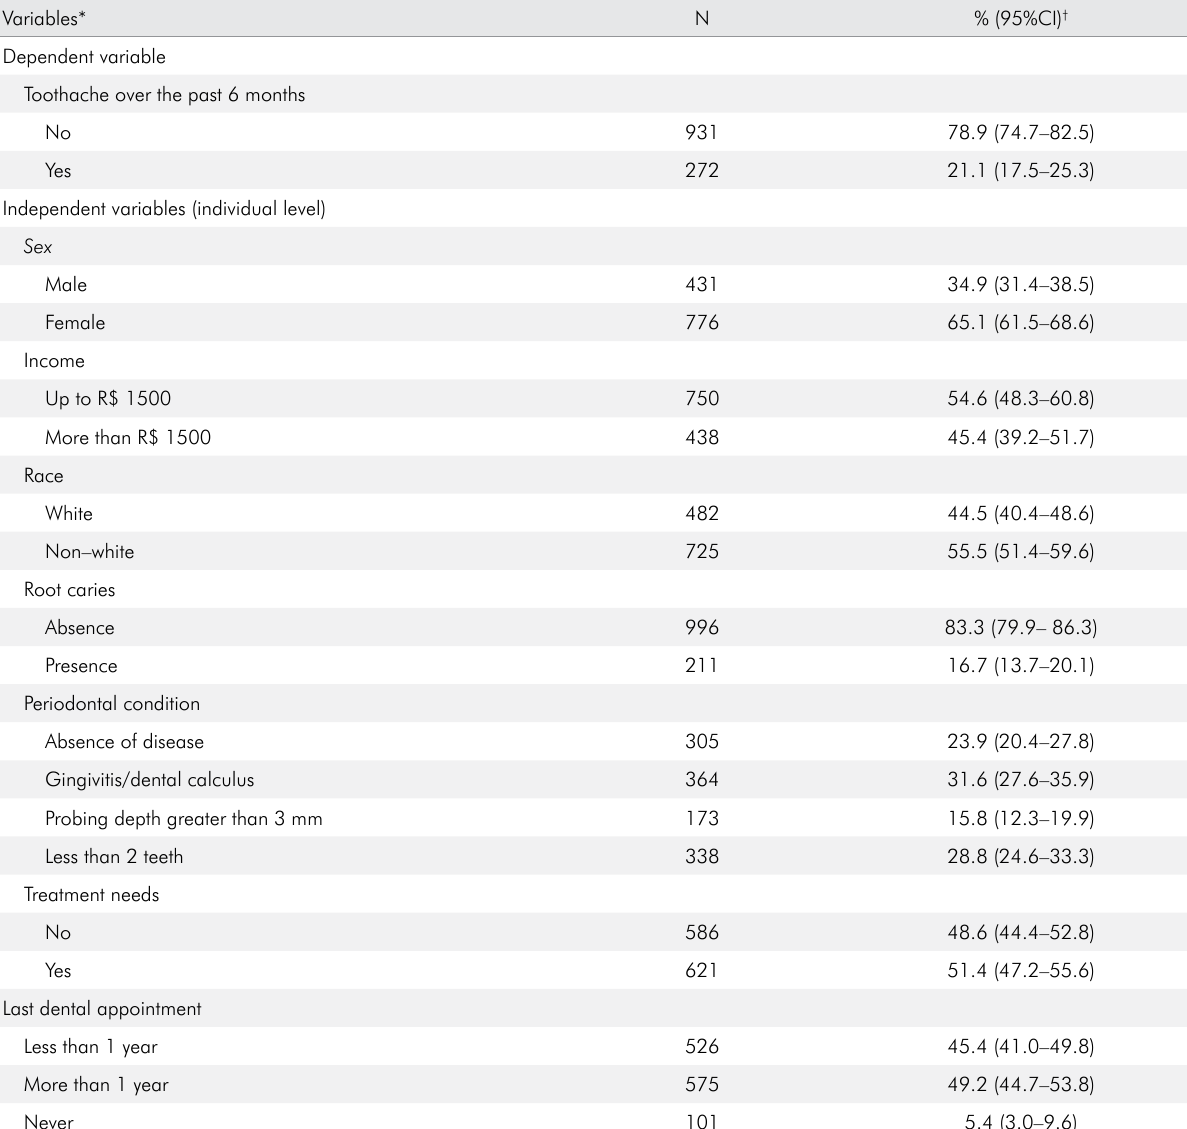
Table 2. Descriptive analysis of individual variables of adults (n=1,207) from Minas Gerais, Brazil, 2012. Variables* N % (95%CI)